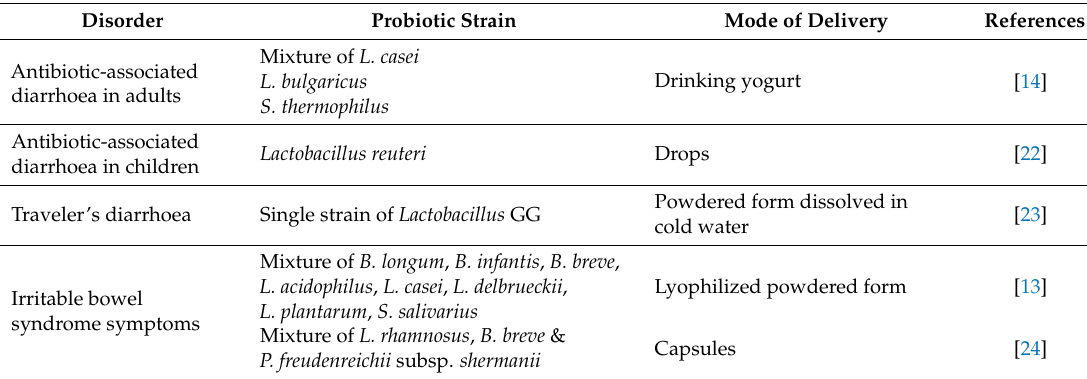
Table 2. Examples of beneficial effects of therapeutic probiotic application in